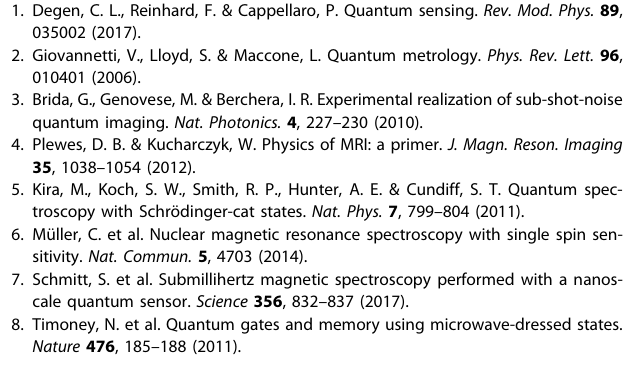
Fig. 5 The sequence diagram of the experiment. The whole cycle could be divided into three stages. Stage 1 consists of cooling, initialization, and preparation of the state 1 j i (the fi rst blue zone) and the state D j i (the fi rst green zone). At Stage 2 (the pink zone of length t D ), we allow the ion interacts with the target fi eld at the interval [0, t 2 ] (the yellow zone), where t 2 ≤ t D . In stage 3, we transfer the state D j i back to 0 j i and detect the probability of 0 j i .